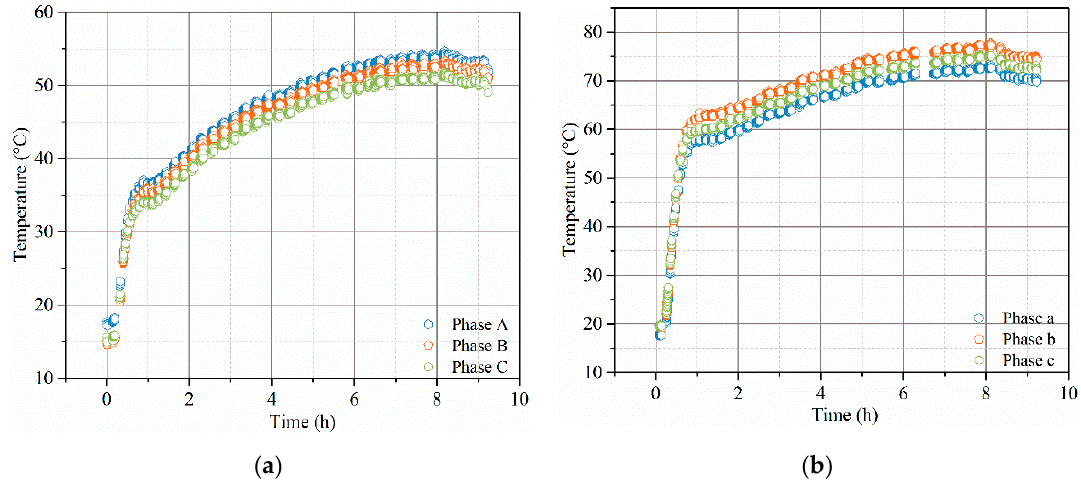
Figure 13. Hotspots transient temperature changes of ( a ) HV windings and ( b ) LV windings.